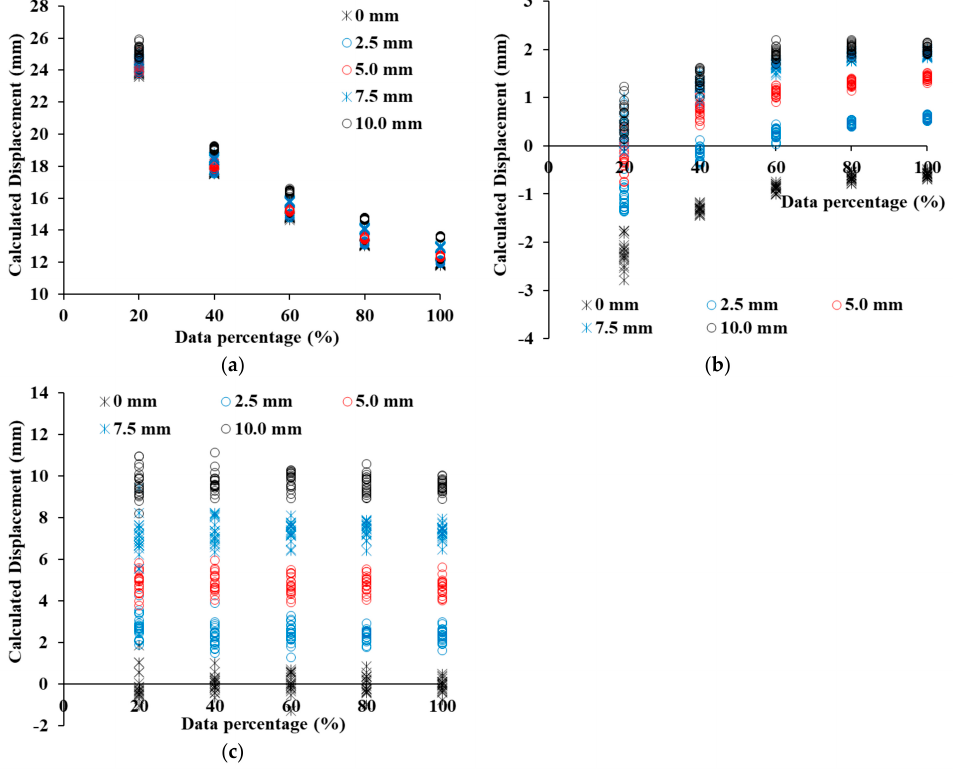
Figure 12. Displacement estimation in a concrete panel, ( a ) Displacement calculated by C2C, ( b ) Displacement calculated by C2M, ( c ) Displacement calculated by M3C2. Table 1. Displacement errors of C2C, C2M, and M3C2 in a concrete